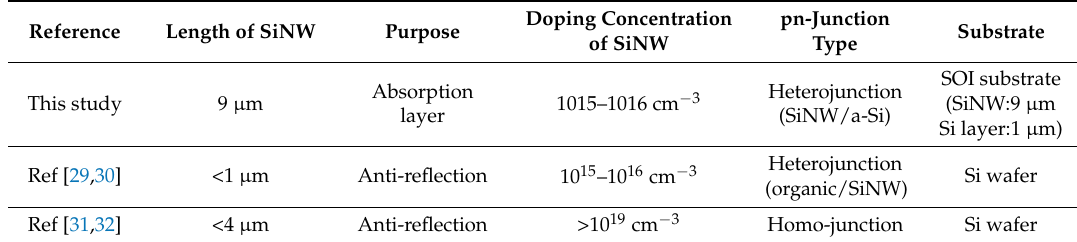
Table 1. The silicon nanowire (SiNW) characteristic and its structure in solar cell between the reported literatures and this